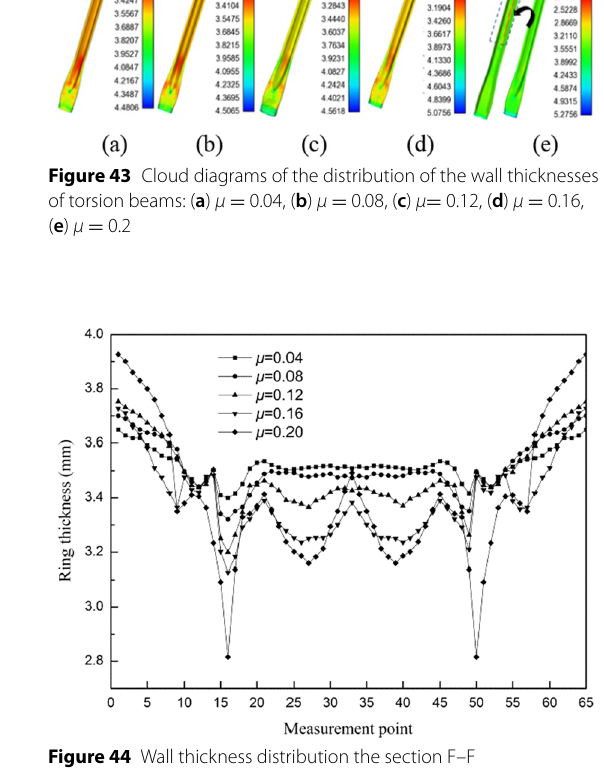
Figure 44 Wall thickness distribution the section